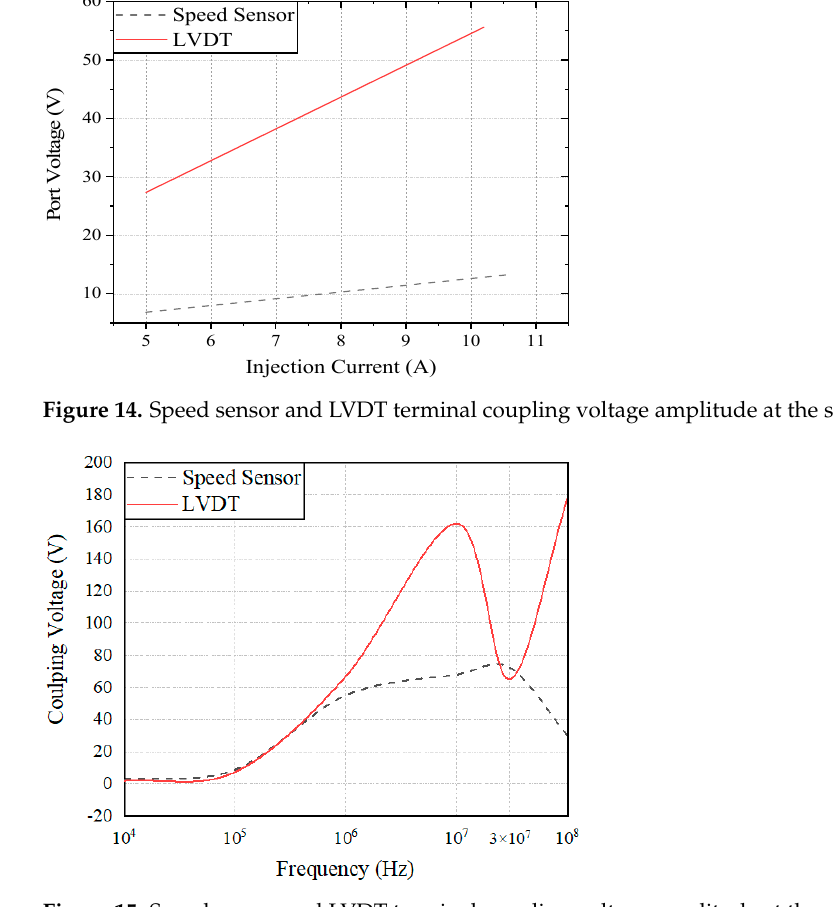
Figure 15. Speed sensor and LVDT terminal coupling voltage amplitude at the multifrequency.